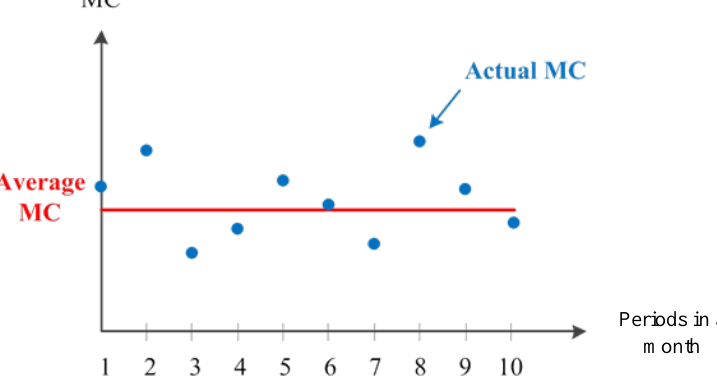
Figure 3. The assumed actual moisture content of woods in a month.